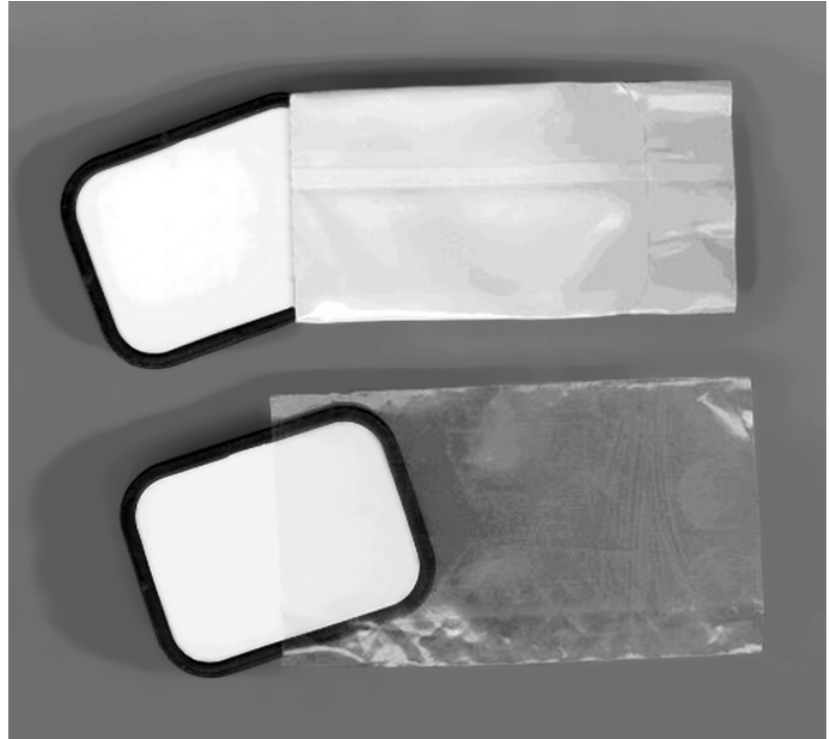
FIGURE 2- Transparent and opaque plastic cases for the optical